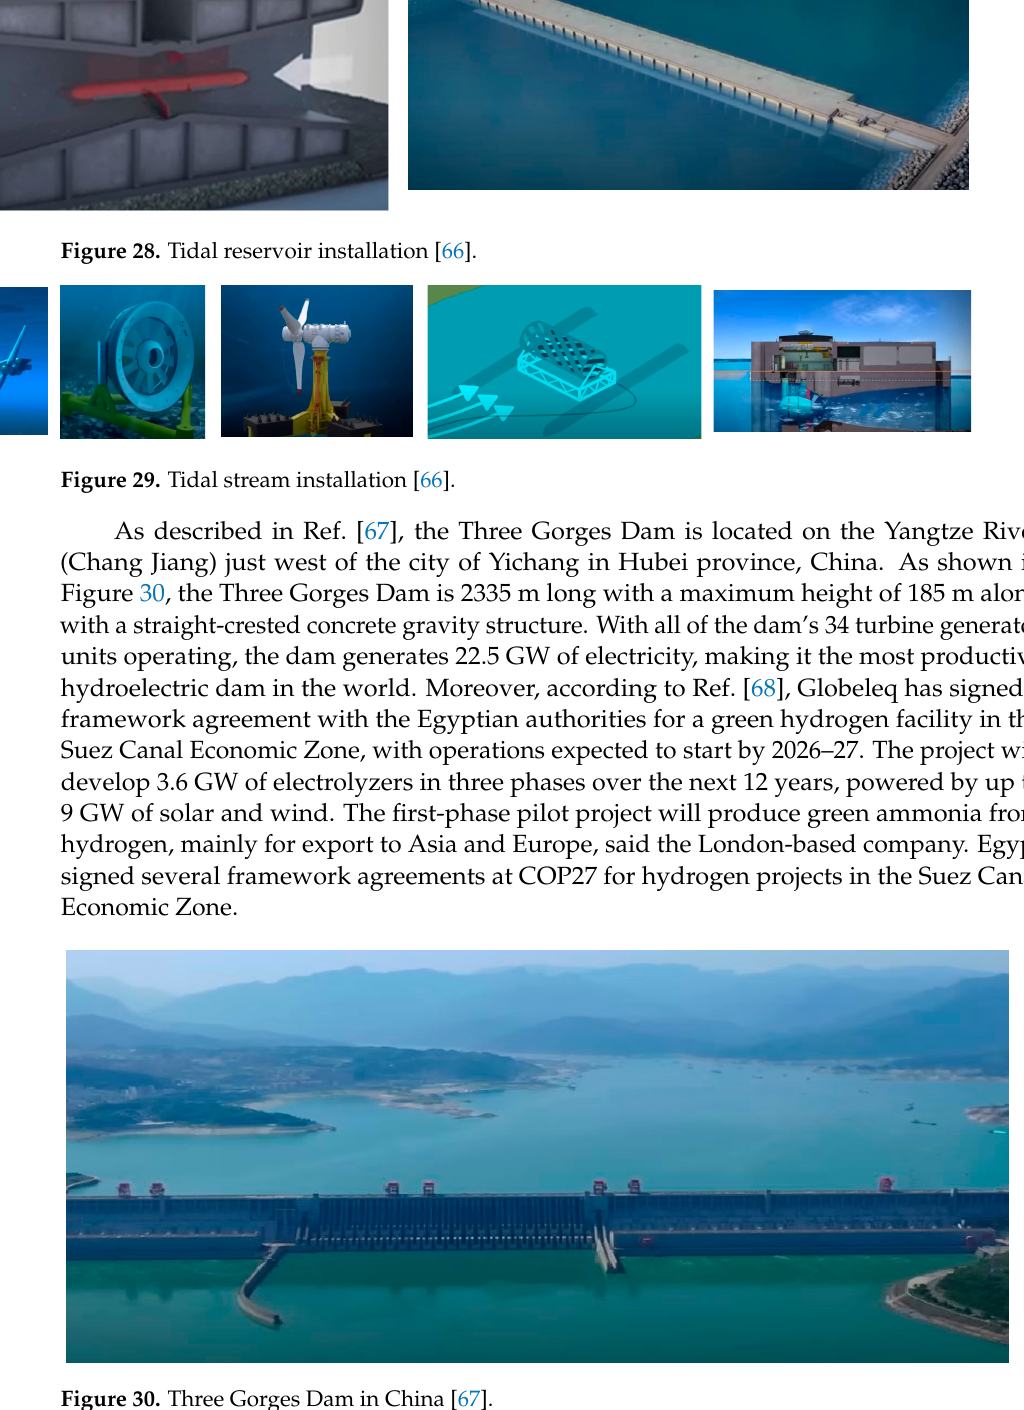
Figure 30. Three Gorges Dam in China